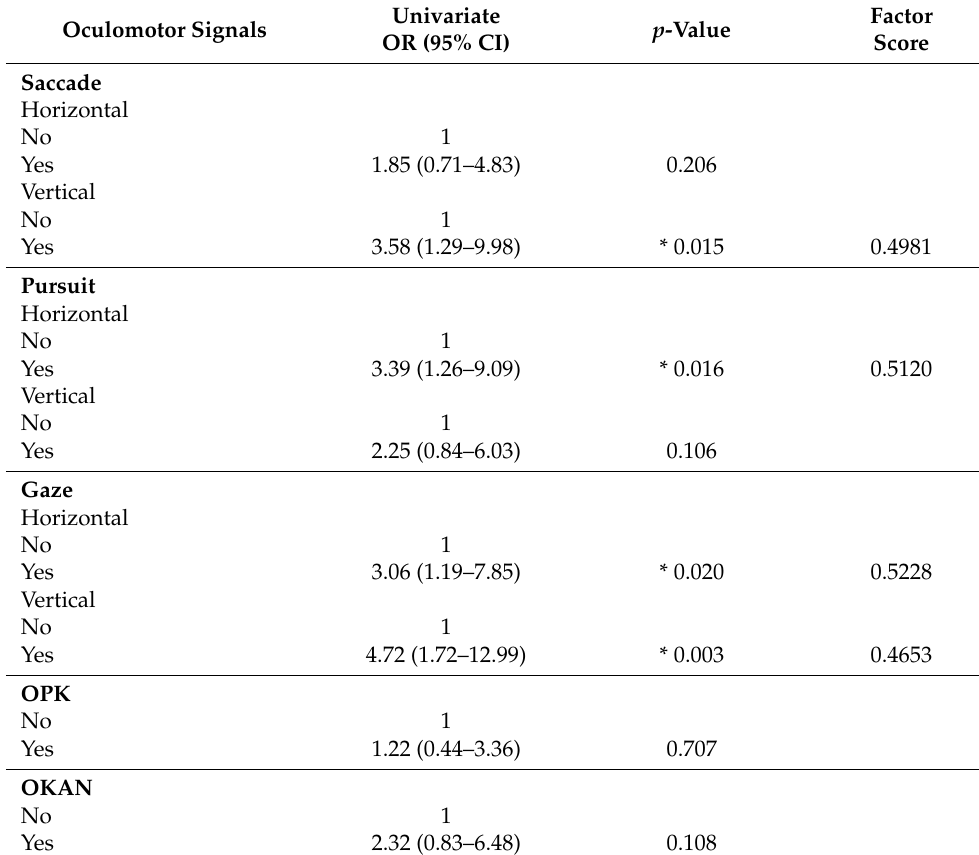
Table 5. Univariate analysis of oculomotor signals predicting abnormal brain MRI. The “factor score” was calculated via principal component analysis of significantly predictive tests ( n =